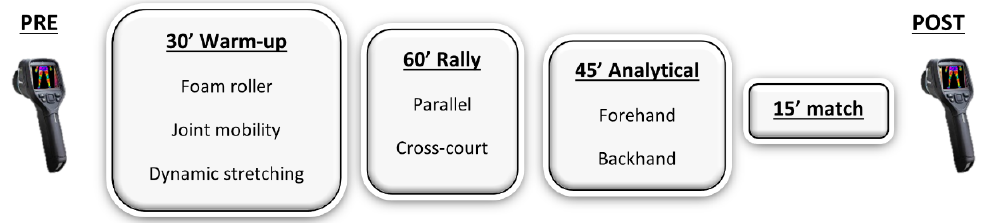
Figure 1. Standardised training protocol and timing outline.